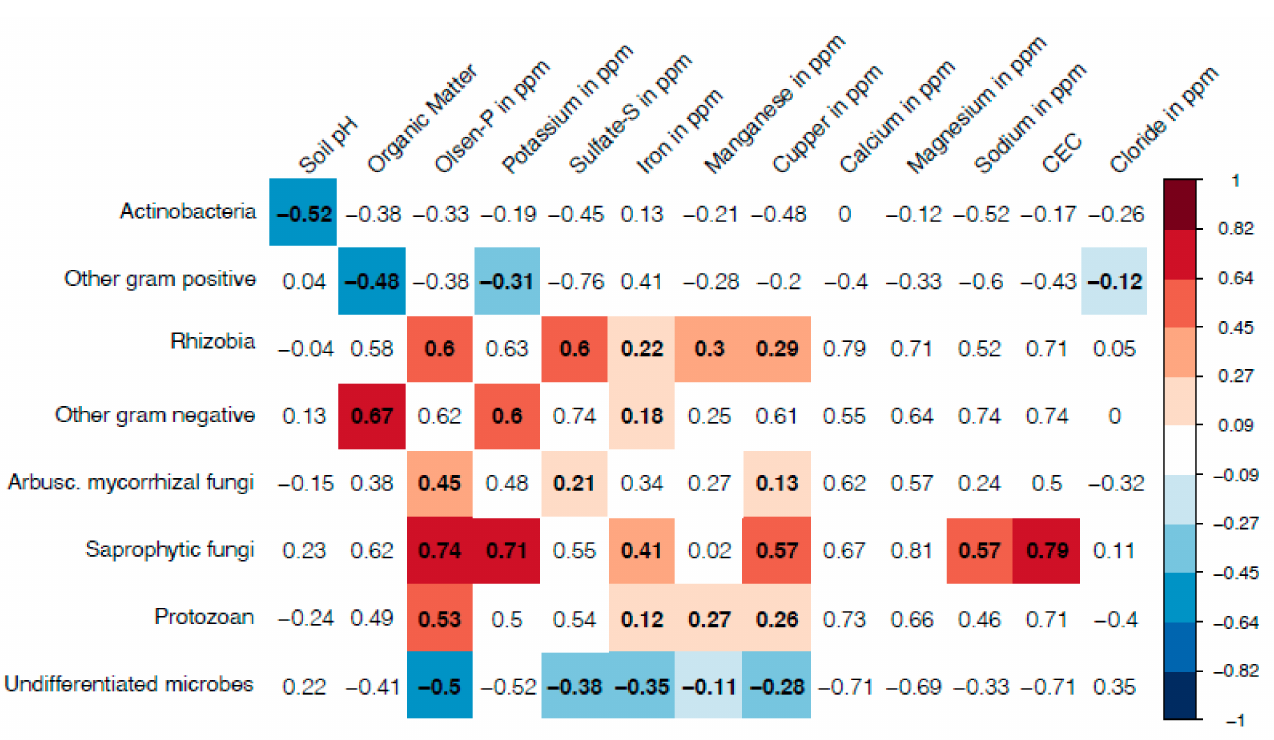
Figure 3. Correlation heat map relating soil chemistry data to PLFA soil microbial groups for the 2018 sampling year. Scale shows the Spearman rank correlation coefficient. Only significant ( p < 0.05) relationships are shown in colored